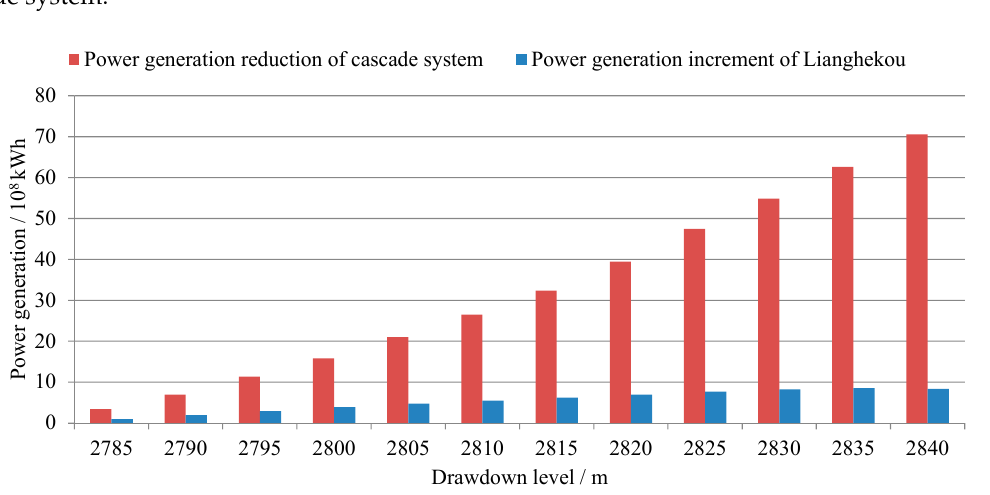
Figure 11. Comparison of reduction of cascade total power generation and increment of Lianghekou power generation.